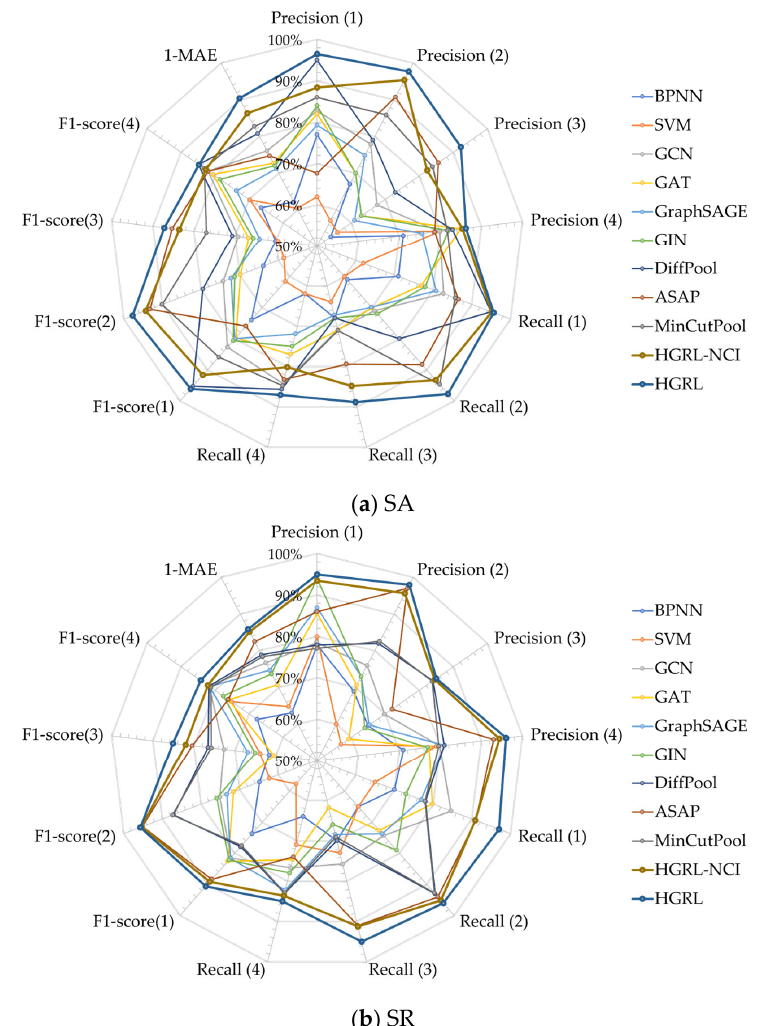
Figure 11. Evaluation performance of different methods of SA and SR in radar chart.